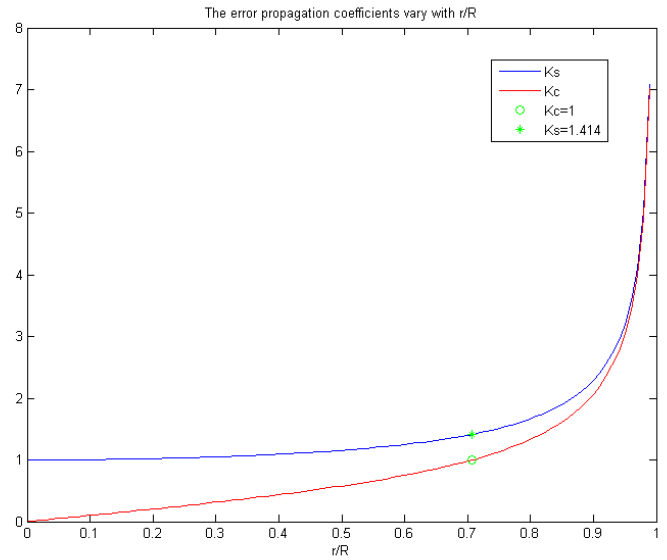
Figure 9. Error propagation coefficients. The blue line represents the variability of Ks with r/R ; the red line represents the variability of Kc with r/R . The green dot is located at (0.707, 1) along the red line; the green crosshair is located at (0.707, 1.414) along the blue line.